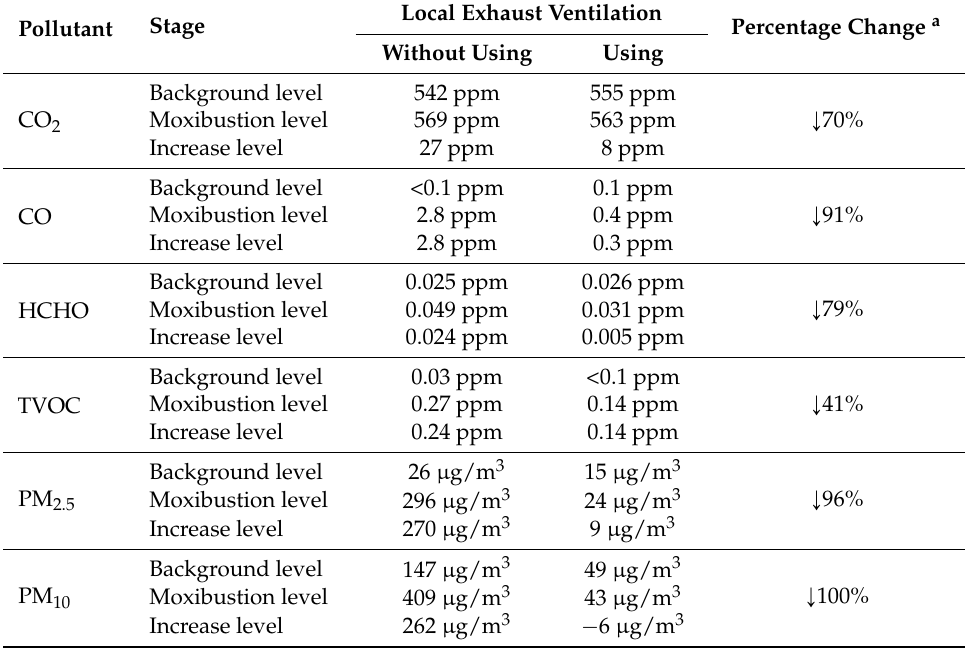
Table 2. Comparison between average values of mean levels of air pollutants emitted from burning new moxa wools with and without local exhaust